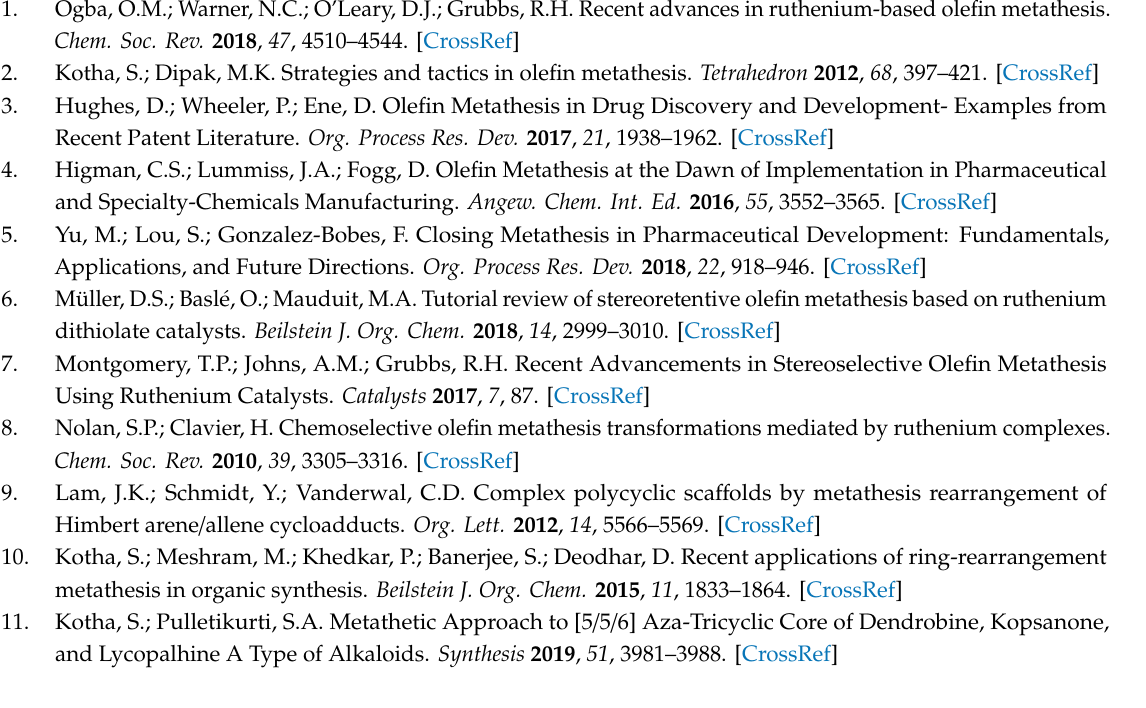
for 6eA and 6eB , Table S2: Bond Lengths for 6eA , Table S3: Bond Angles for 6eA , Table S4: Hydrogen Bonds for 6eA , Table S5: Bond Lengths for 6eB , Table S6: Bond Angles for 6eB , Table S7: Hydrogen Bonds for 6eB , Table S8: Crystal data and structure refinement for 8b , Table S9: Bond Lengths for 8b , Table S10: Bond Angles for 8b , Table S11: Hydrogen Bonds for 8b , Table S12: Selected 1 H-NMR chemical shifts for trans - and cis -isomers, Table S13: Selected 13 C-NMR chemical shifts for trans - and cis